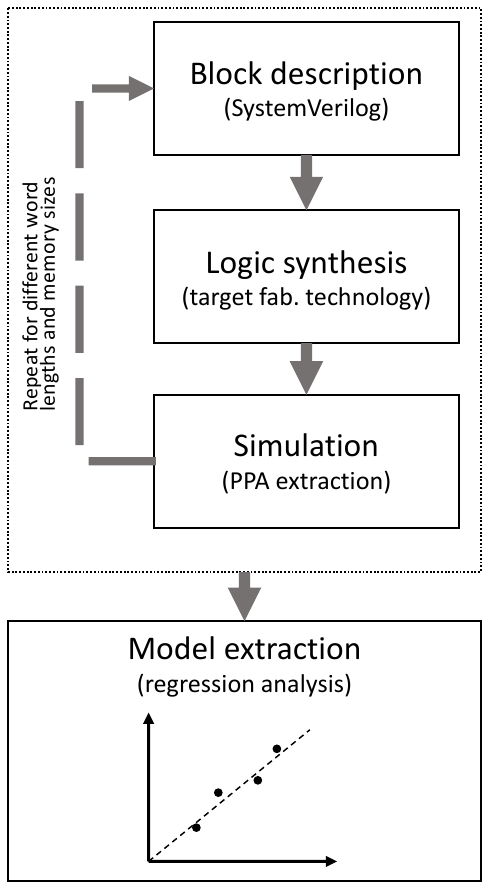
Figure 3. Scheme of model extraction procedure for the PAMPIUM basic